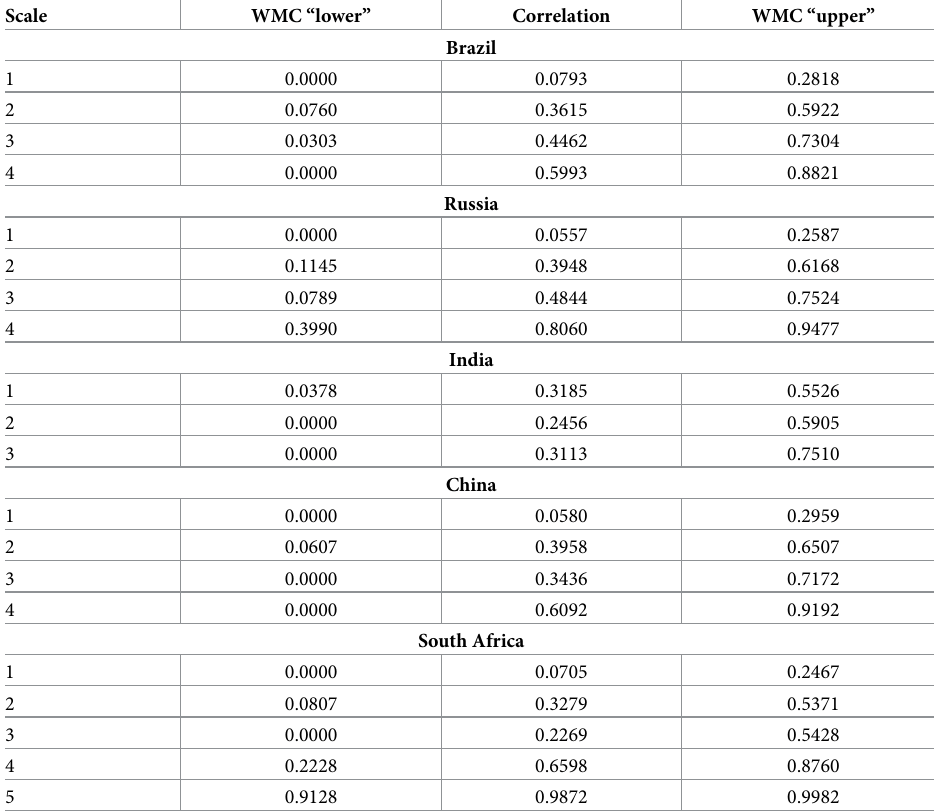
Table 5. Wavelet multiple correlations